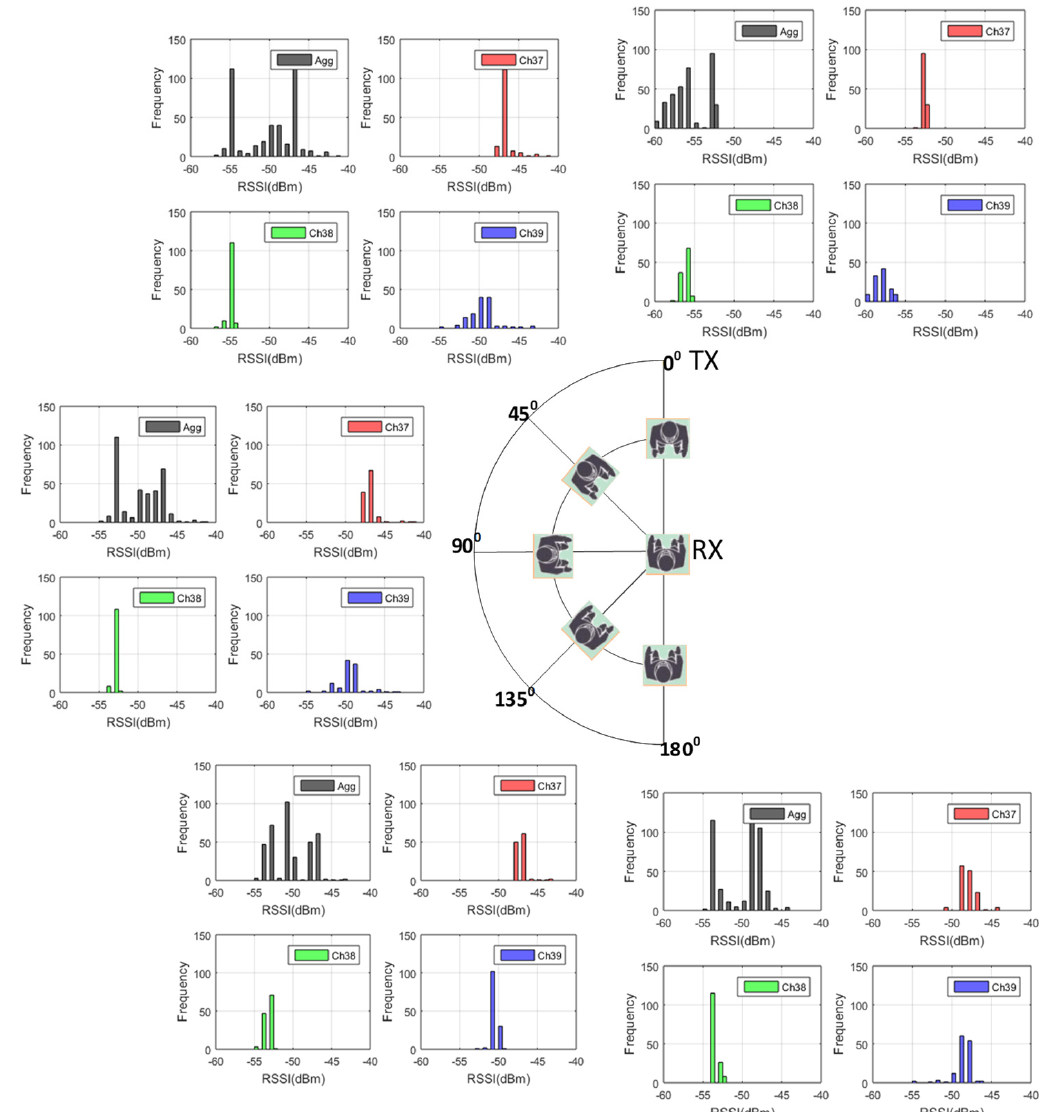
Figure 11. The RSSI samples received from the three advertising channels and aggregate signals in comparison with different blockage angles. Table 1. Mean and standard deviation of the RSSI measurements.